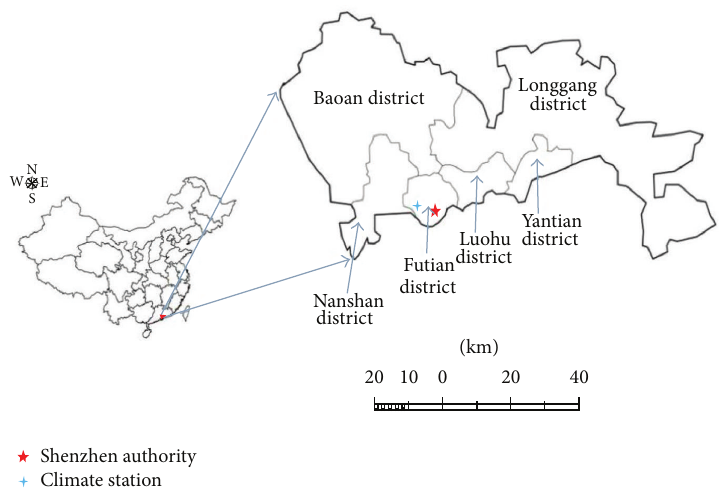
Figure 1: Schematic diagram of the research region (Shenzhen) and the meteorological